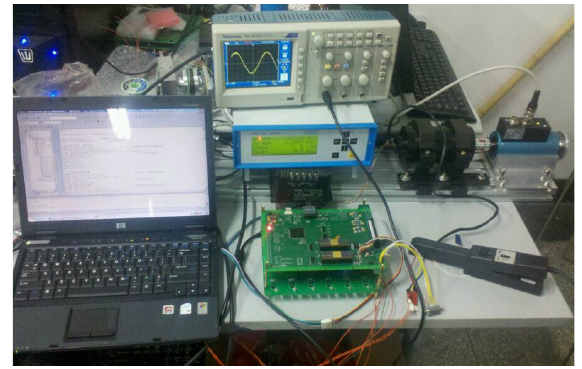
Figure 12. Test bench for measuring torque at load.